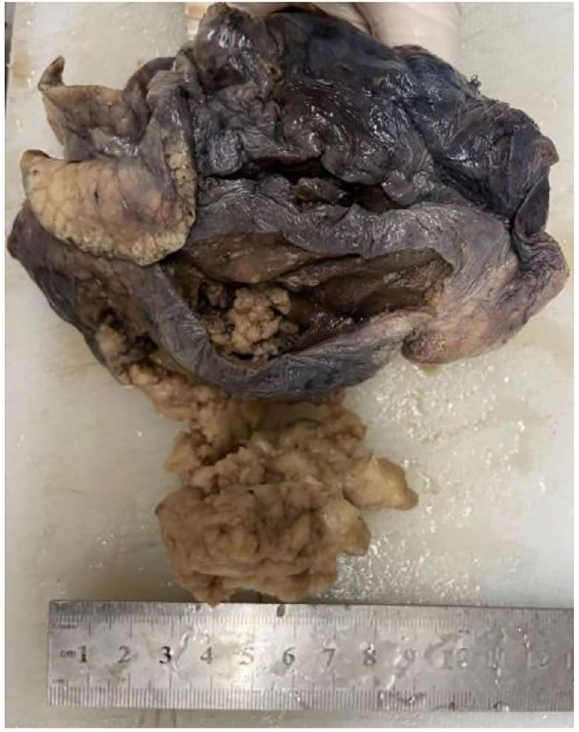
Fig. 2 Grossly, the cut surface of the tumor was gray white, solid and gran- ular, without an envelope, and has a clear boundary with the surrounding lung tissue